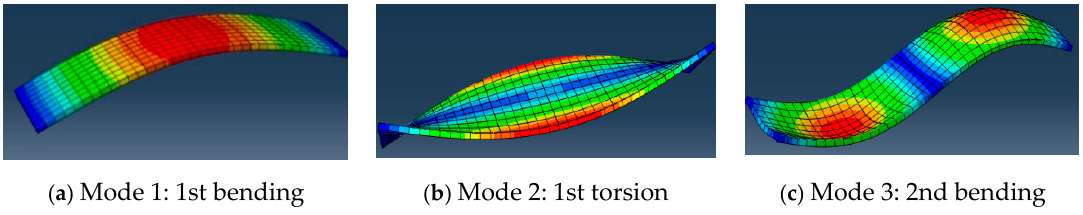
Figure 8. Vibration mode shapes of slab model (Intact: Case 0).